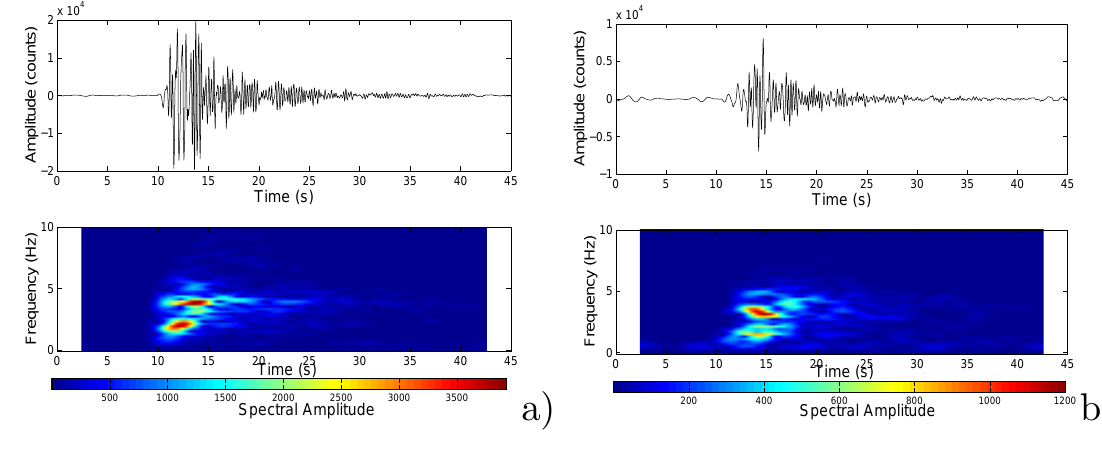
Fig. 6. Waveform and spectrogram of the radial component of the event (27/02/05h, 23:40:24 UT) recorded at two stations located at (a) about 700m (E1S) and (b) about 2km (CON) from the lava lake. The spectrogram was estimated by Fast Fourier Transform (FFT) with a sliding Hanning window. It is extracted from De Lauro et al. (2009b). The 2 and 4Hz main peaks in the spectrogram are shifted in time and the lower frequency (2Hz) precedes the higher one (4Hz) at E1S. No time delay is visible at CON. This might be related to dispersive